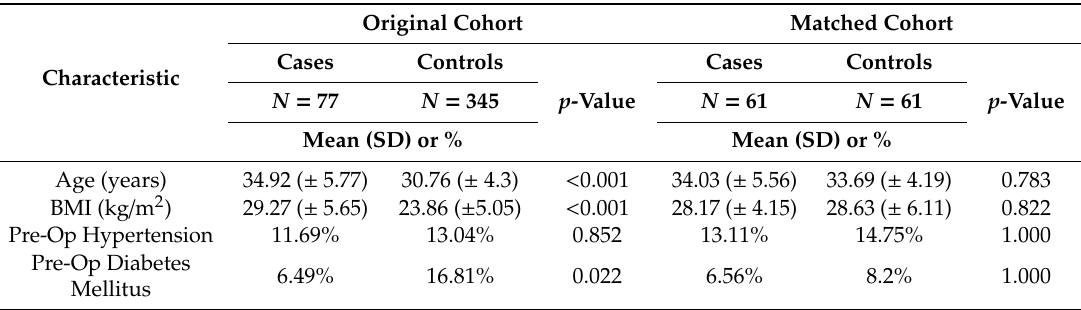
Table 2. Demographic characteristics.